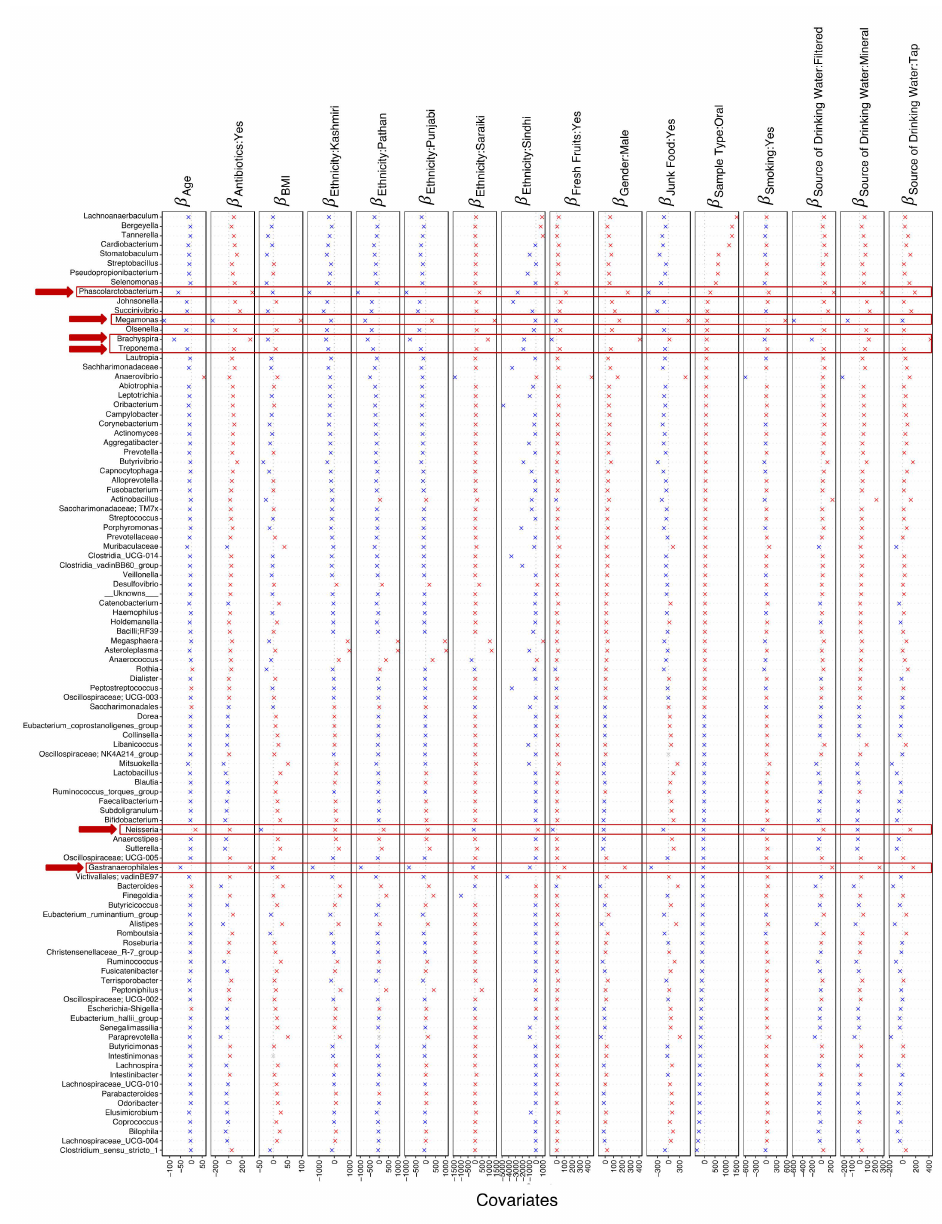
Figure 4. β − coefficients returned from GLLVM procedure for covariates considered in this study. Top 100 most abundant genera were considered, incorporating both continuous data (age, BMI) as well as categorical labelling of samples. Those coefficients which are positively associated with the microbial abundance of a particular species are represented in red colour whilst those that are negatively associated are represented with blue colour, respectively. Since the collation of ASVs was performed at genus level, ASVs that cannot be categorized based on taxonomy are collated under the “__Unknowns__” category. Genera that stand out in terms of significances with multiple covariates are highlighted with a red